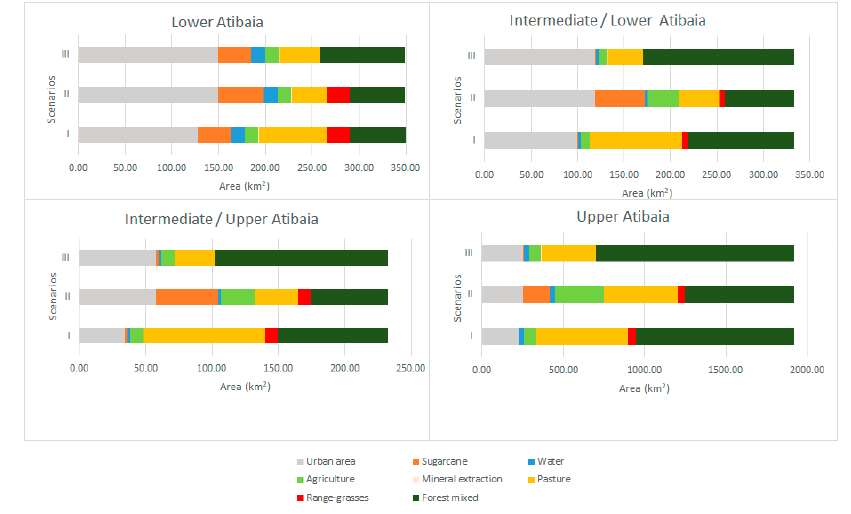
Figure 2. Area extent of land use change classes for the basin. Table 2. Land use areas related to each scenario and sub-basin.